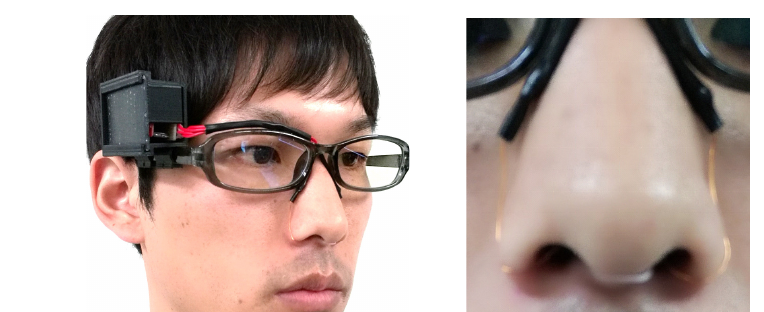
Figure 4. Prototype device [2].